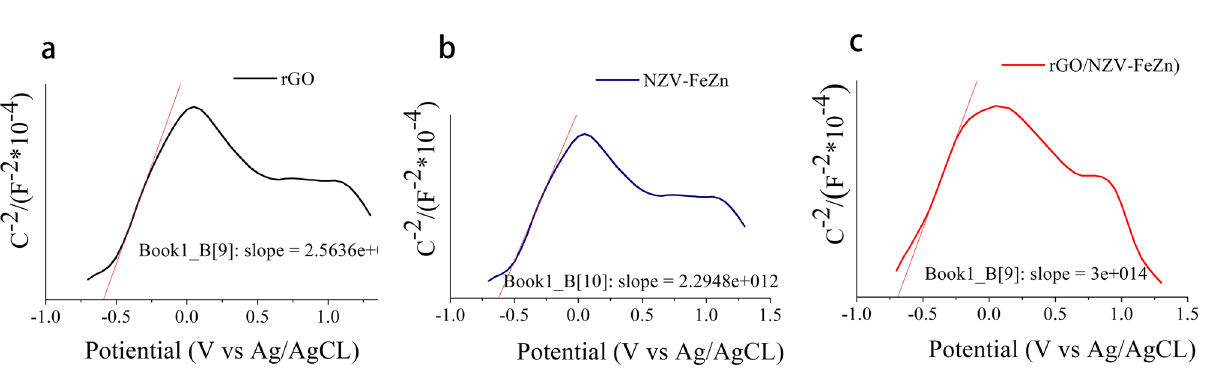
Figure 12. Mott–Schottky plots of ( a ) rGO, ( b ) NZV-FeZn, and ( c )